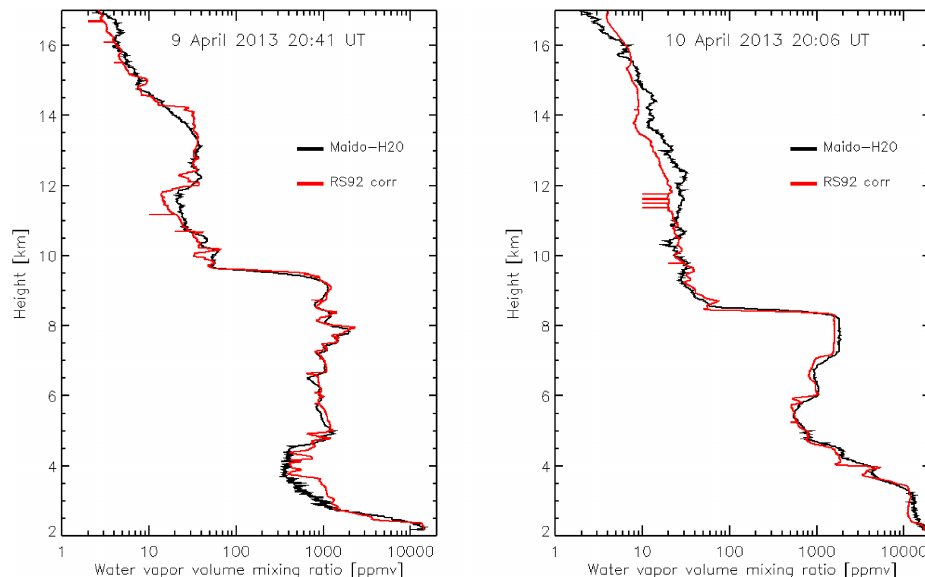
Figure 10. Example of two water vapor mixing ratio profiles measured simultaneously by the Maïdo lidar and the RS92 radiosondes (black and red curve, respectively) during the nighttime measurement sessions of 9 and 10 April.